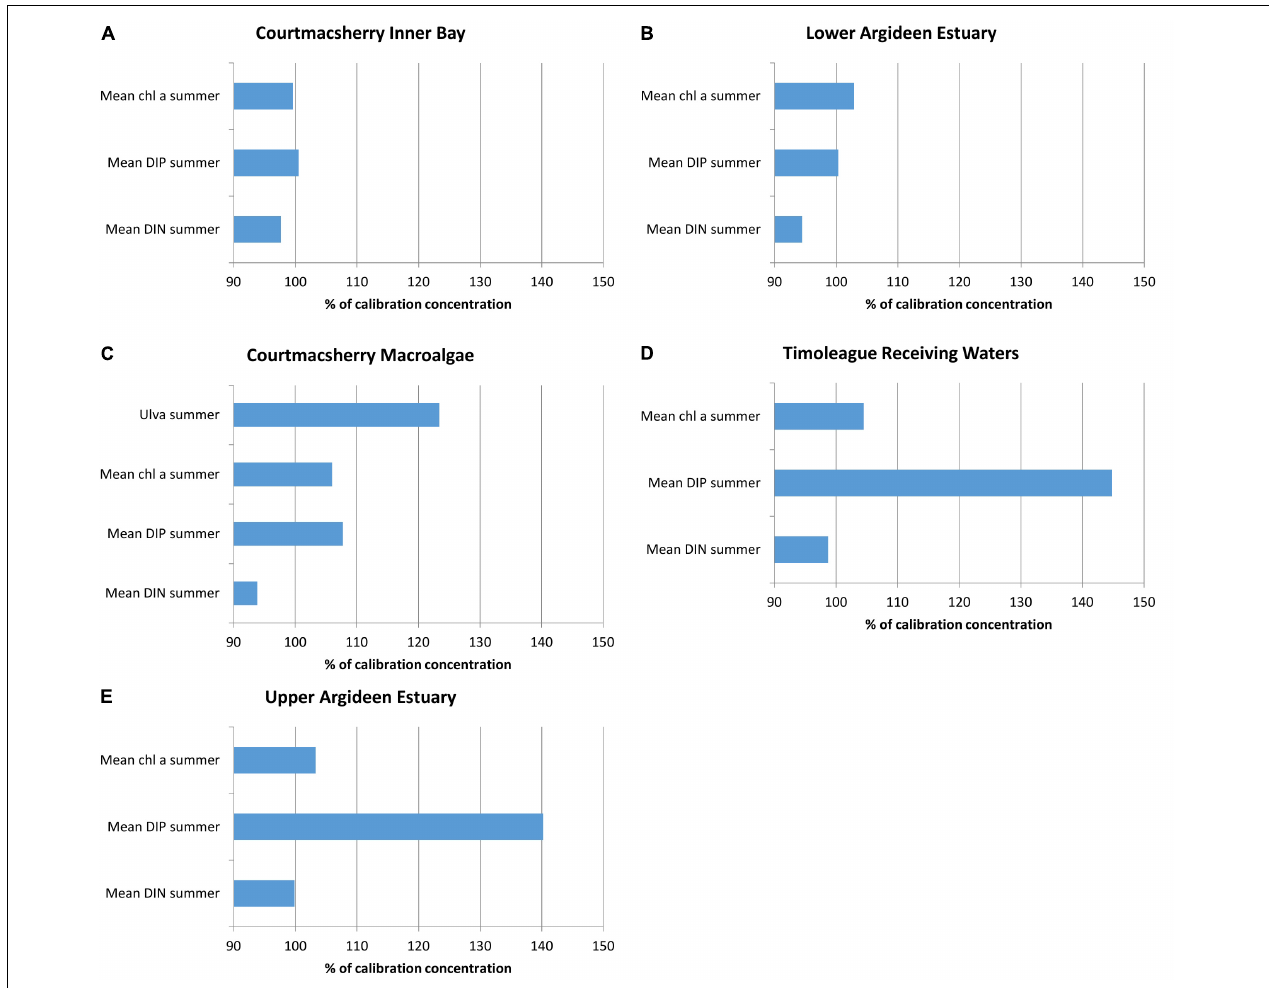
FIGURE 6 | Percentage change in DIN, DIP, chlorophyll a and macroalgae due to imposition of flow load relations for 2016 to 2010 flow data (scenario 1) in (A) Courtmacsherry Inner Bay, (B) the Lower Argideen Estuary, (C) the Courtmacsherry macroalgae zone, (D) the Timoleague Receiving Waters, and (E) the Upper Argideen